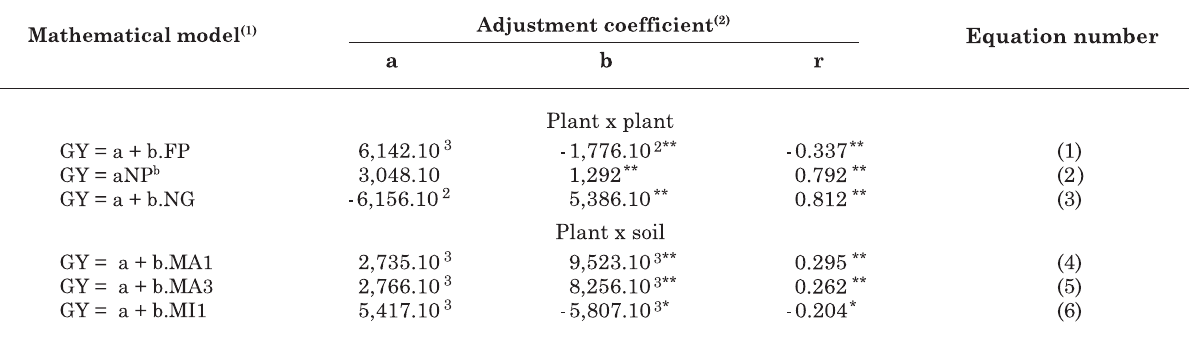
Table 4. Equations and regression coefficients for attributes of soybean yield and soil (dystroferric Red Latosol)